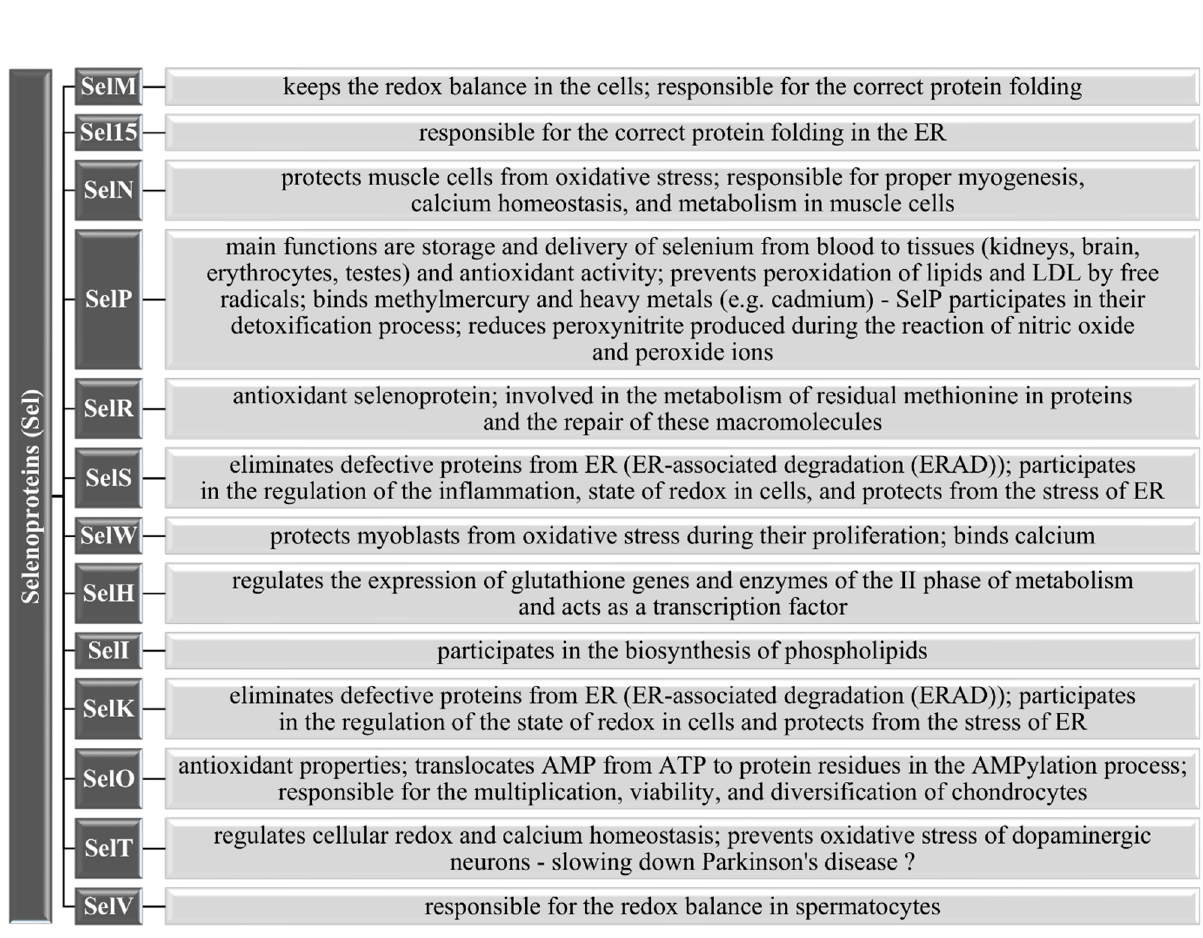
Figure 6. Other selenoproteins and their functions